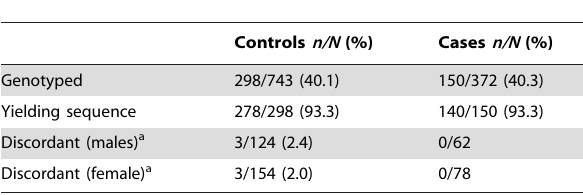
Table 4. Sample description for genotyped samples.